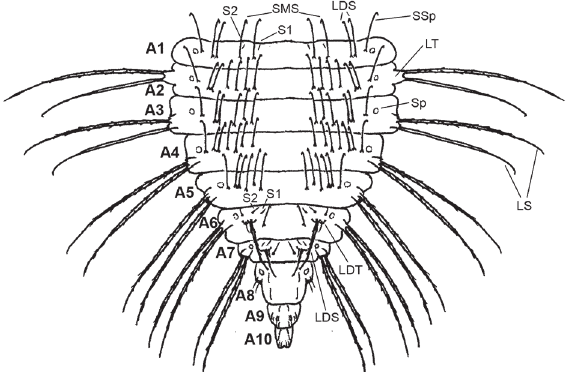
Figura 12. Abdome do primeiro instar de C. caligata , vista dorsal. (A1-A10) Primeiro ao 10º segmentos abdominais, (LDS) cerda no tubérculo látero-dorsal, (LDT) tubérculo látero-dorsal, (LS) cerda no tubérculo lateral, (LT) tubérculo lateral, (SMS) cerda submediana, (Sp) espiráculo, (SSp) cerda associada ao espiráculo, (Sx)